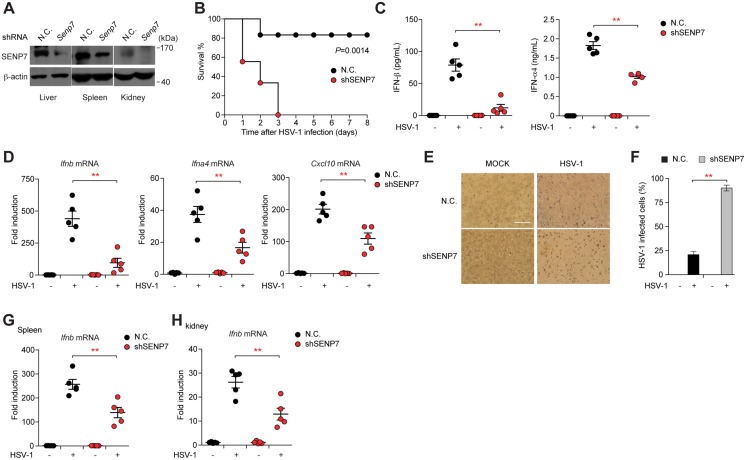
SENP7 is indispensable for the innate defense against HSV-1 infection.(A) Immunoblot analysis of SENP7 in lysates of liver, kidney and spleen from mice at 48 hr after transfection with Senp7 or nonspecific (N.C.) shRNA. (B) Survival of mice (n = 9 per group) transfected with Senp7 or N.C. shRNA and 48 hr later injected intravenously with HSV-1. P = 0.0014 (Mantel-Cox test). (C) ELISA of IFN-β and IFN-α4 in serum from mice (n = 5 per group) transfected with Senp7 or N.C. shRNA and 48 hr later injected intravenously with HSV-1, assessed 6 hr after HSV-1 infection. (D) Quantitative PCR of relative Ifn-b, Ifn-a4 and Cxcl10 mRNA in livers from mice (n = 5 per group) transfected with Senp7 or N.C. shRNA and 48 hr later injected intravenously with HSV-1, assessed 6 hr after HSV-1 injection. (E, F) Brains of the HSV-1-infected mice (n = 6 each) were harvested for immunohistochemistry (IHC) analysis by an anti-HSV-1 antibody. Tissue sections were visualized by microscopy (E). Percentages of cells infected by HSV-1 were quantified (F). (G, H) Quantitative PCR of relative Ifn-b mRNA in spleen (G) or kindey (H) from mice (n = 5 per group) transfected with Senp7 or N.C. shRNA and 48 hr later injected intravenously with HSV-1, assessed 6 hr after HSV-1 injection. Graphs show the mean ± s.d. and data shown are representative of at least two experiments. *P < 0.05, **P < 0.01 (two-tailed t-test). Scale bars, 50 μm.